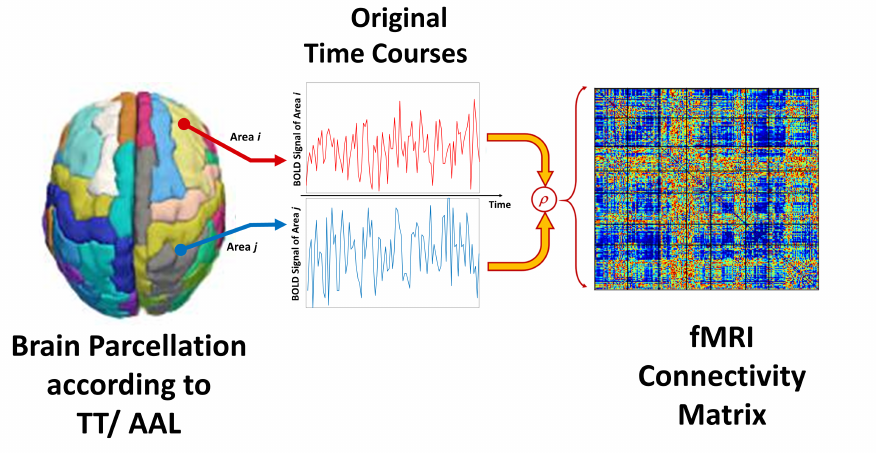
Figure 2. Visual diagram of the calculations of the static functional connectivity FC representation, extracted from two different brain